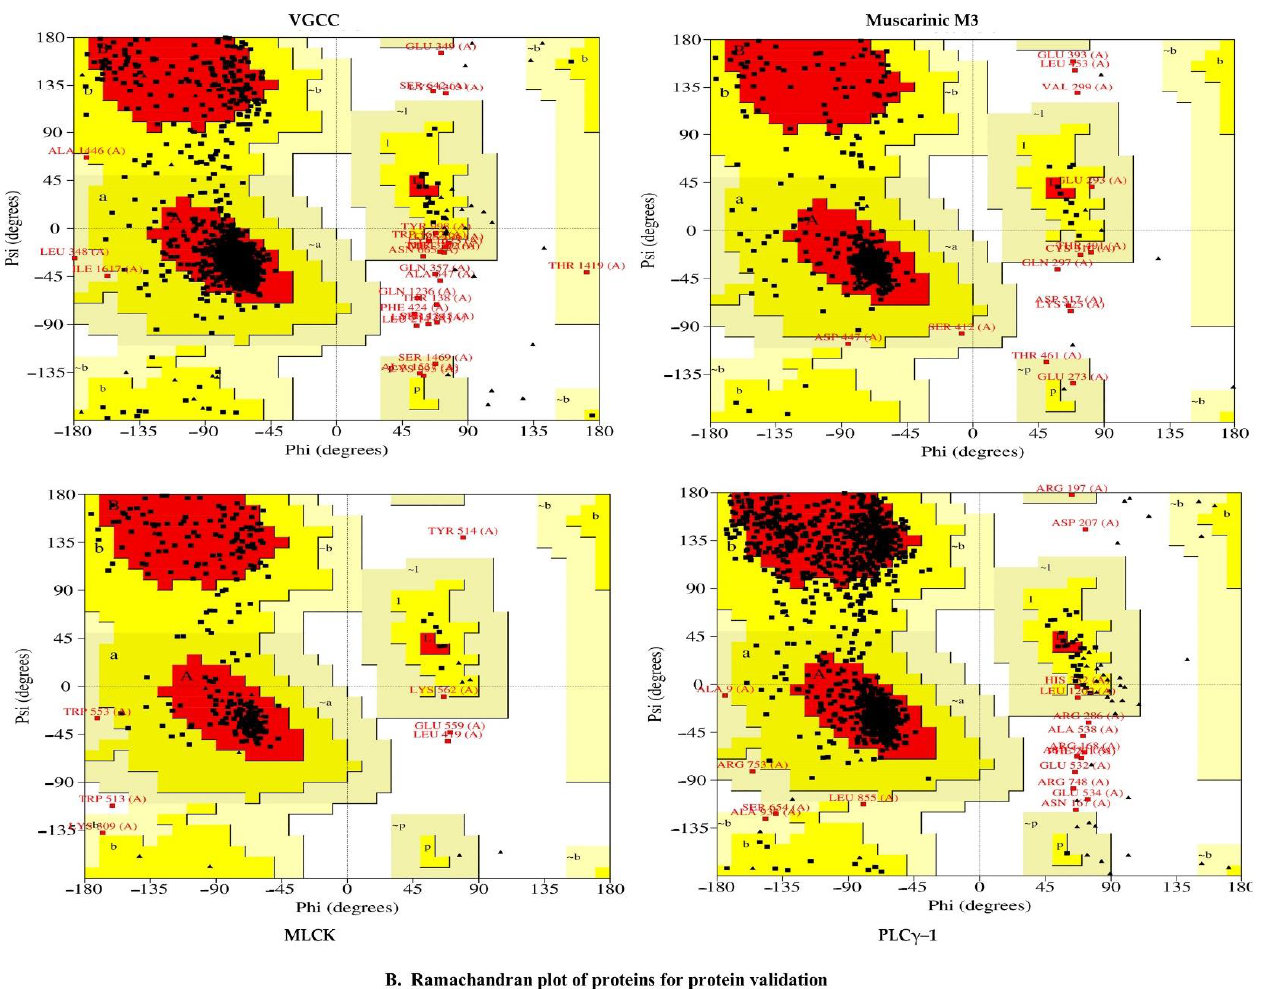
Figure 3. ( A ) Secondary structures and ( B ) Ramachandran plots of protein homology models. Phi and Psi are the dihedral (torsion) angles of amino acid bonds. The regions of Ramachandran plots are labelled as follows: A: core alpha; a: allowed alpha; ~a: generous alpha; B: core beta; b: allowed beta; ~b: generous beta; L: core left-handed alpha; l: allowed left-handed alpha; ~l: generous left-handed alpha; p: allowed epsilon; and ~p: generous epsilon. VGCC: Voltage gated calcium channel; MLCK: myosin light chain kinase; PLC γ − 1: Phospholipase C gamma 1 2.6. Molecular Docking Molecular docking calculations may be used to determine the position of the ligand inside the binding pockets of the target proteins. The physical energy terms such as solv- ation energy are combined with a suitable force field for docking calculation accuracy [33,34]. The results are shown in Figures 4 and 5, and Table 1.